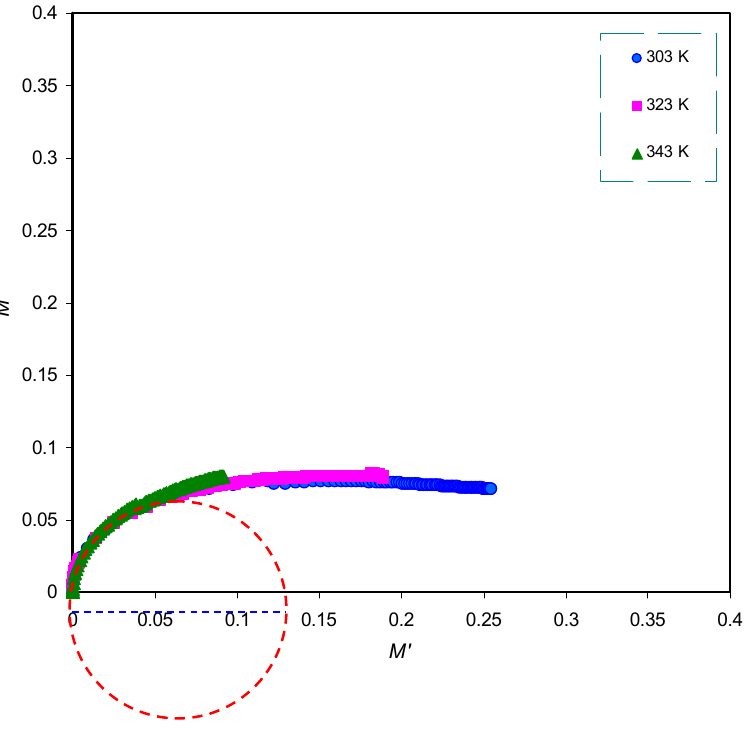
Figure 10. Argand plot at selected temperatures for PVA:LiFC 3 SO 3 solid electrolyte. The incomplete semicircles indicate the distribution of relaxation times.